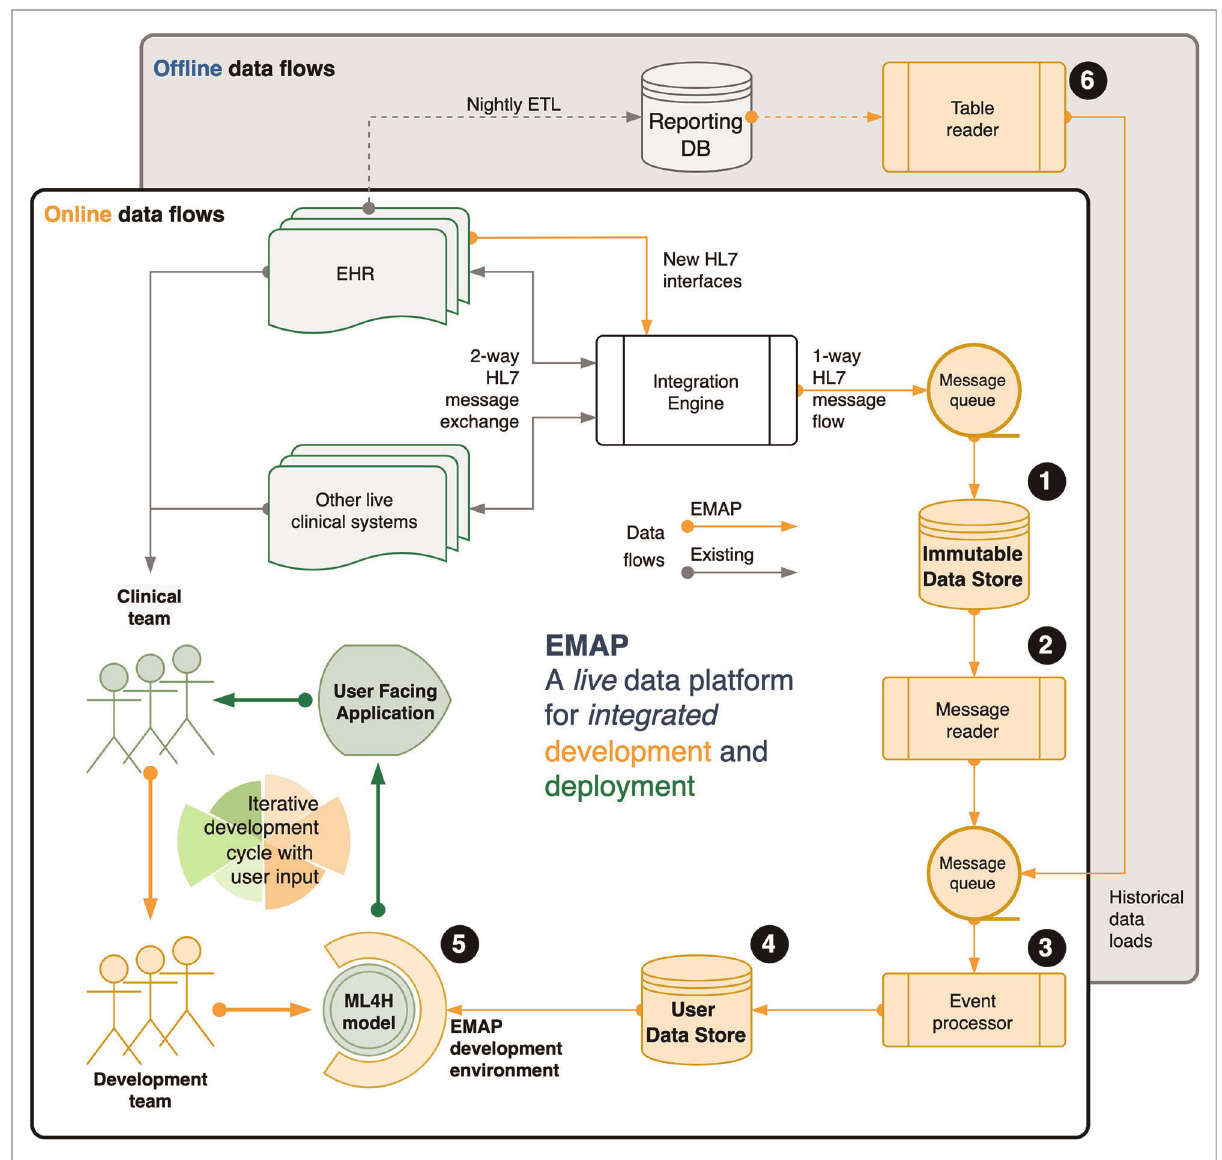
FIGURE 1 Our real-world development is performed on the Experimental Medicine Application Platform (EMAP). EMAP is a clinical laboratory within which ML4H researchers can iteratively build, test and gather feedback from the bedside. It uni fi es the data and the tools for off-line and online development of ML4H models (see fi gure and the (numbers) in the following sentences that refer to objects in the fi gure). In brief, EMAP builds a patient orientated SQL database from Health Level 7 version 2 (HL7v2) messages that are being exchanged between hospital systems. HL7v2 messages are ubiquitous in health care, and the de facto standard for internal communication. Rather than multiple pairwise connections between different hospital electronic systems, an integration engine acts as a single hub that routes HL7 messages, and where necessary translates to ensure compatibility. EMAP copies each message passing through the integration engine to a PostgreSQL database, the Immutable Data Store (IDS) (1) . A message reader (2) processes each live message to an interchange format so that downstream processing is insulated from local HL7 implementation. Separately, the table reader (6) processes historical data (e.g. from the reporting database) to the same interchange format. Live messages take priority over historical messages in a queue that feeds the event processor (3) . This links each message to a patient and a hospital visit, makes appropriate updates for out of order messages, and merges when separate identi fi ers are recognised to represent the same patient. A full audit trail is maintained. Each event updates a second live PostgreSQL database, the User Data Store (UDS) (4) . The hospital hosts Jupyter and RStudio servers, and a Linux development environment is provided that allows docker deployment, installation of analysis libraries and frameworks, exposes SSH and HTTPS services, and allows user veri fi cation against the hospital active directory. (5) A typical work fl ow might include investigation and experimentation in a Jupyter Notebook with data from the UDS, then using a small network of docker containers to run the development script, log outputs to a testing database, and report to users via email or a locally hosted web application or dashboard. A fuller explanation is available in the Supplementary Material (Section 2: EMAP data fl